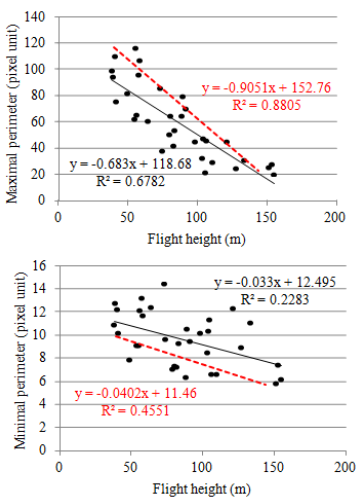
Figure 6: Linear regressions for the determination of maximal and minimal perimeters used in polygons selection. The red lines represent the final equations used as input parameters in the algorithm.